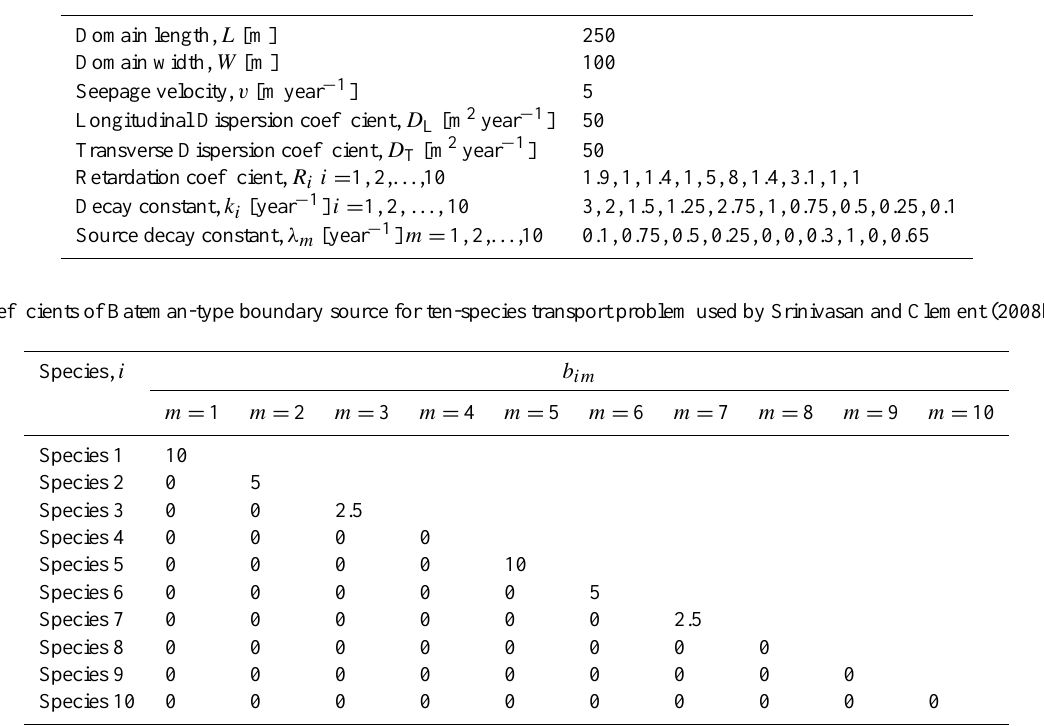
Table 8. Transport parameters used for verification example 2 involving the ten-species transport problem used by Srinivasan and Clement (2008b).